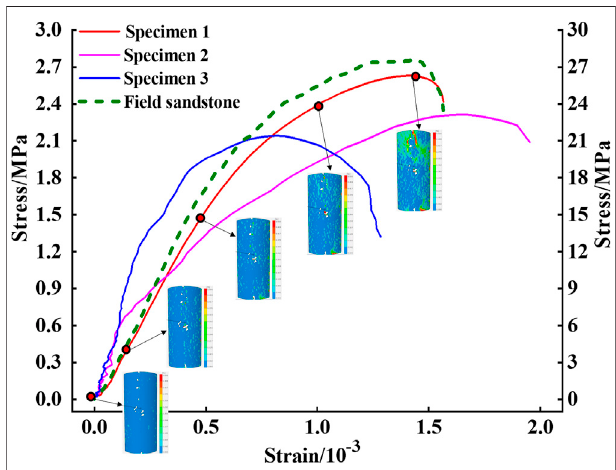
FIGURE 6 | Stress – strain curve of uniaxial